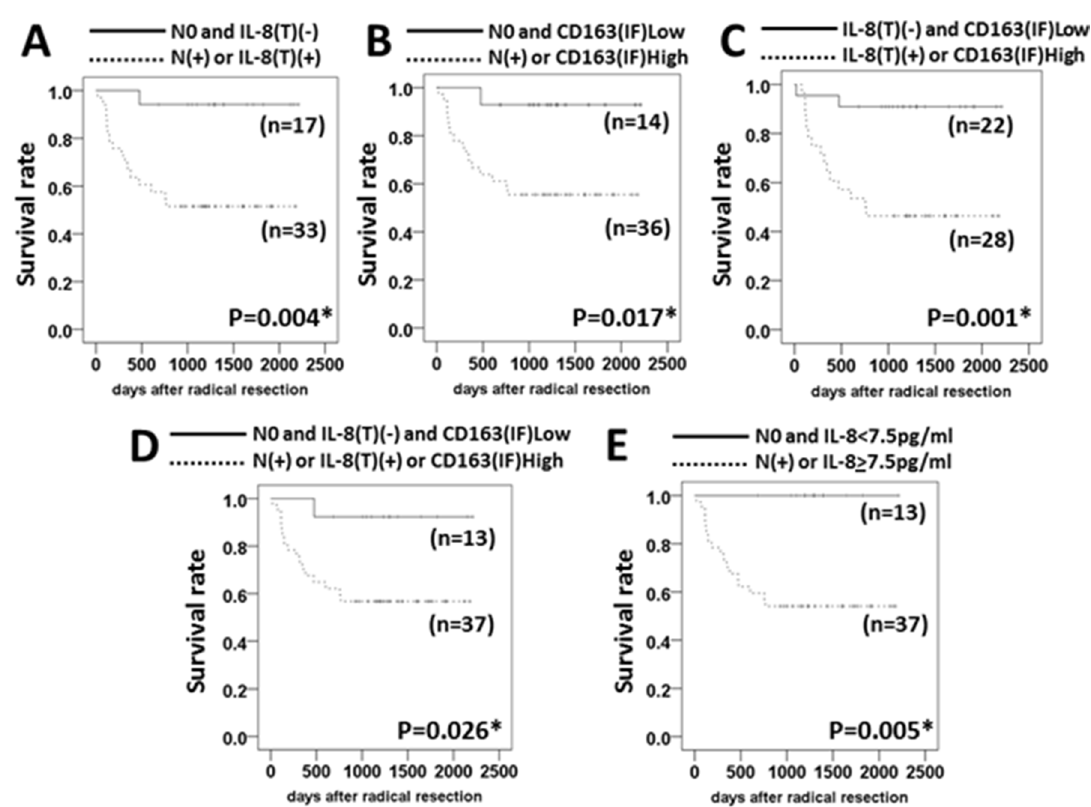
Figure 3. The combination of independent factors for predicting the DFS of OSCC patients. Differences in the DFS of OSCC patients with (A) N0 and IL-8(T)( 2 ) vs. N( + ) or IL-8(T)( + ), (B) N0 and CD163(IF)Low vs. N( + ) or CD163(IF)High, (C) IL-8(T)( 2 ) and CD163(IF)Low vs. IL-8(T)( + ) or CD163(IF)High, (D) N0 and IL-8(T)( 2 ) and CD163(IF)Low vs. N( + ) or IL-8(T)( + ) or CD163(IF)High, (E) N0 and IL-8 , 7 pg/ml vs. N( + ) or IL-8 > 7 pg/ml were calculated by log- rank test. * P ,